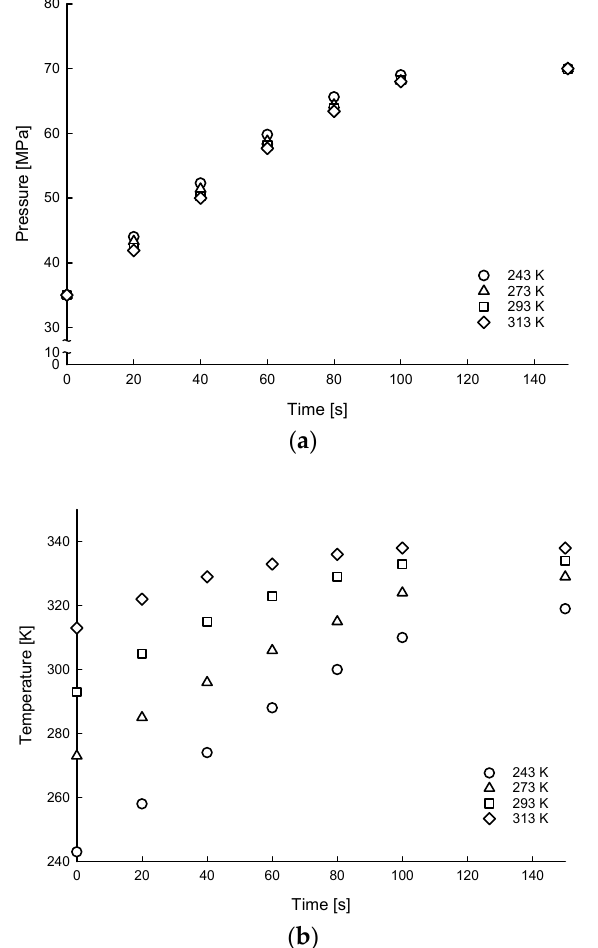
Figure 7. Time histories of hydrogen of average gas pressure ( a ) and temperature ( b ) distributions of filling process for 20 MPa SOC pressure condition under different ambient temperature condi- tions.